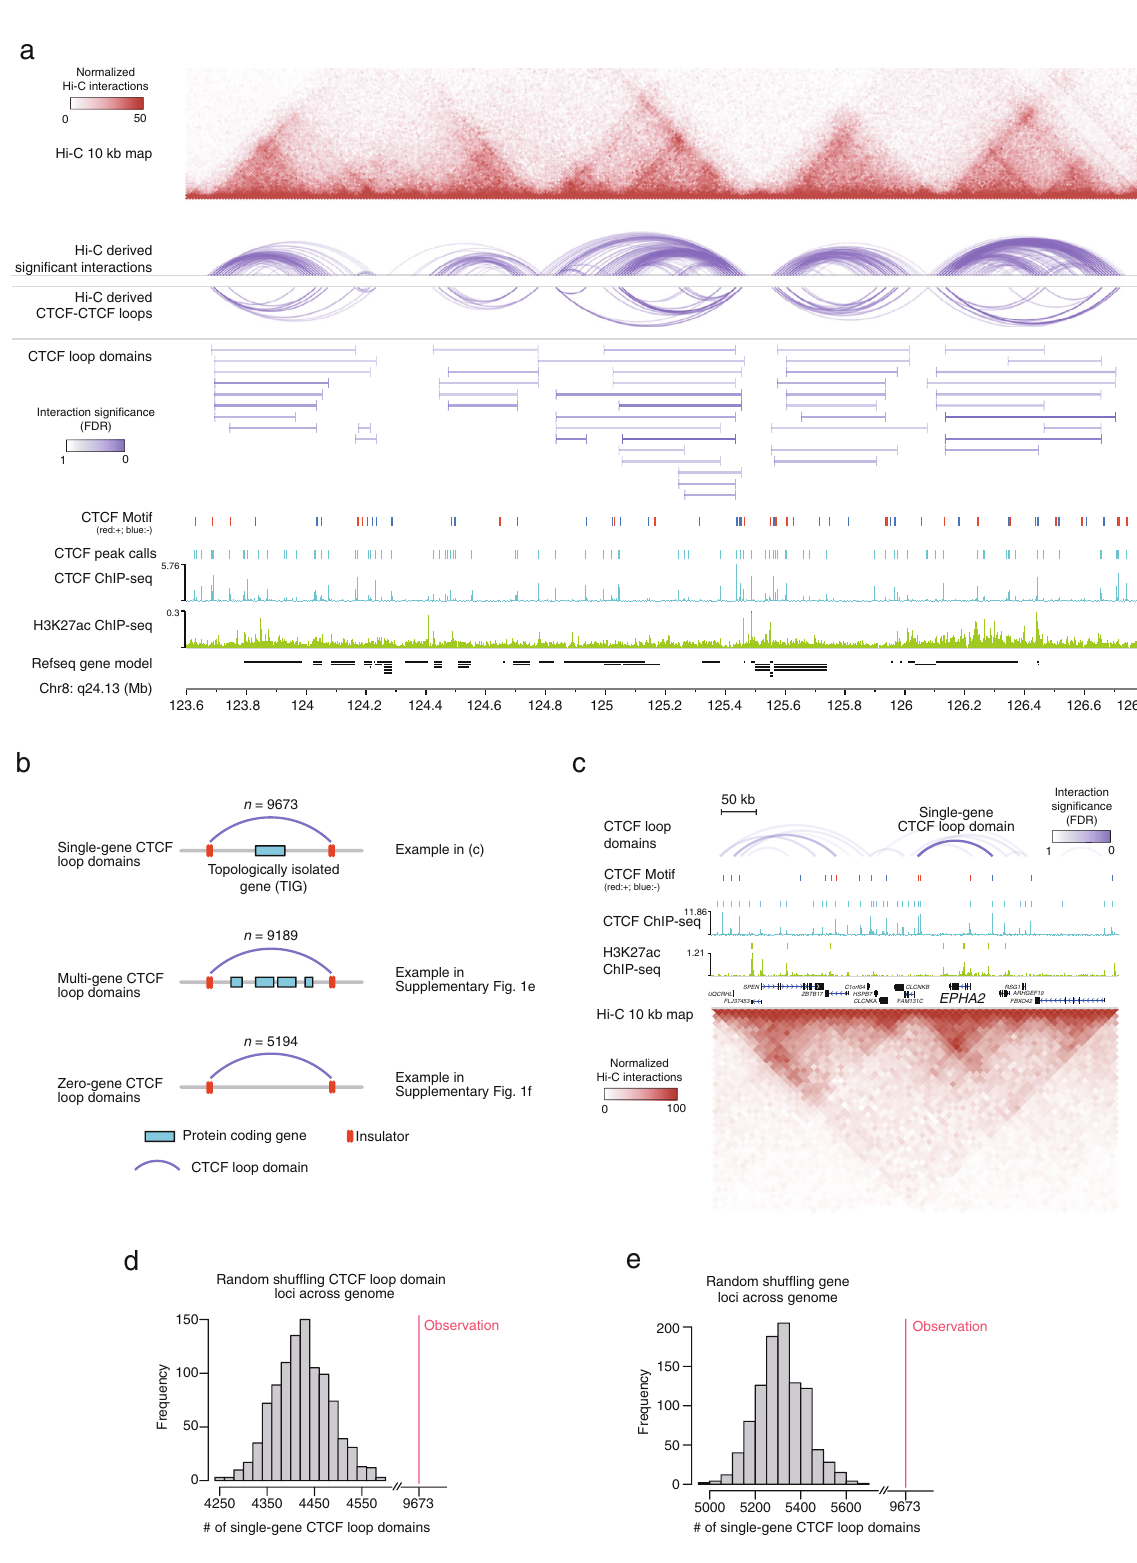
4 C data) and the right heatmap representing the Hi-C interac- tions from the surrounding genomic regions of the right boundaries to the left boundaries (Fig. 2a). For cases in which there are physical interactions between the two boundaries in the sample, the plot exhibits a high intensity in the center of both heatmaps but not the surrounding regions. By investigating